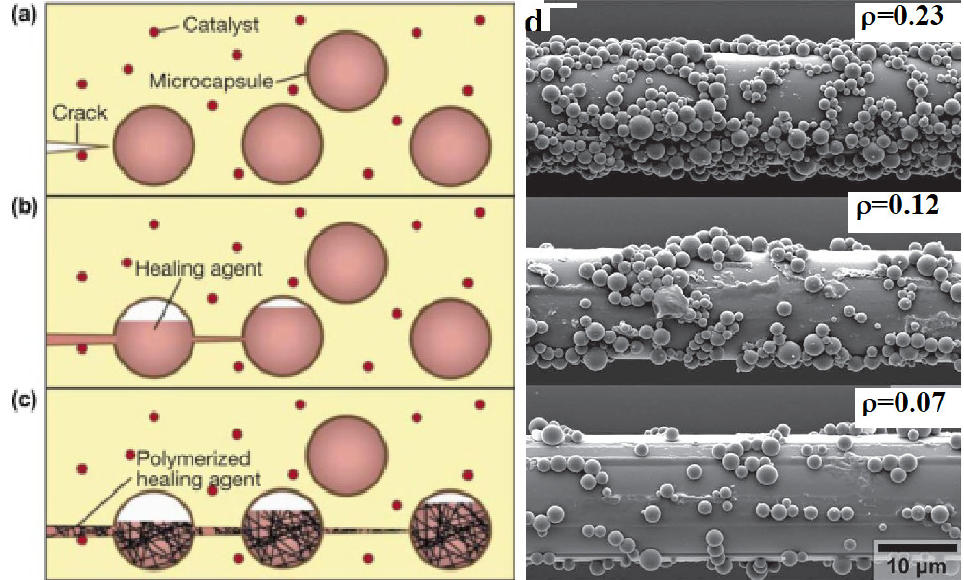
Figure 10. Schematic representation of a self-healing method using microcapsules ( a – c ). Reproduced from [127] with permission from Elsevier. SEM images of fibers functionalized with capsules at various concentrations ρ ( d ). Reproduced with permission from [33]. Copyright (2022) John Wiley and Sons.